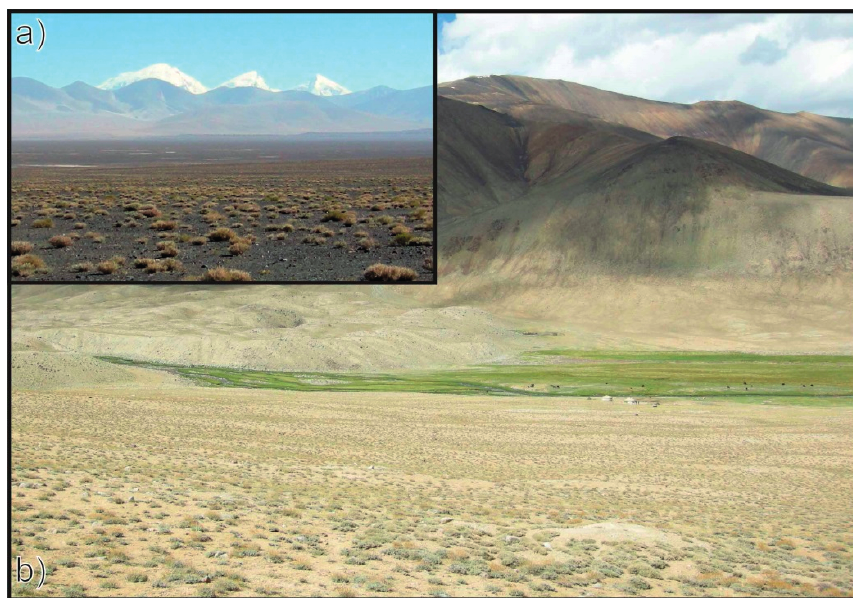
Figure 2. Photographs of ( a ) dwarf shrub stand located within the eastern Hyperion scene taken in fall 2014, and ( b ) dwarf shrub stand located within the western Hyperion scene with azonal grass vegetation in the background taken in summer